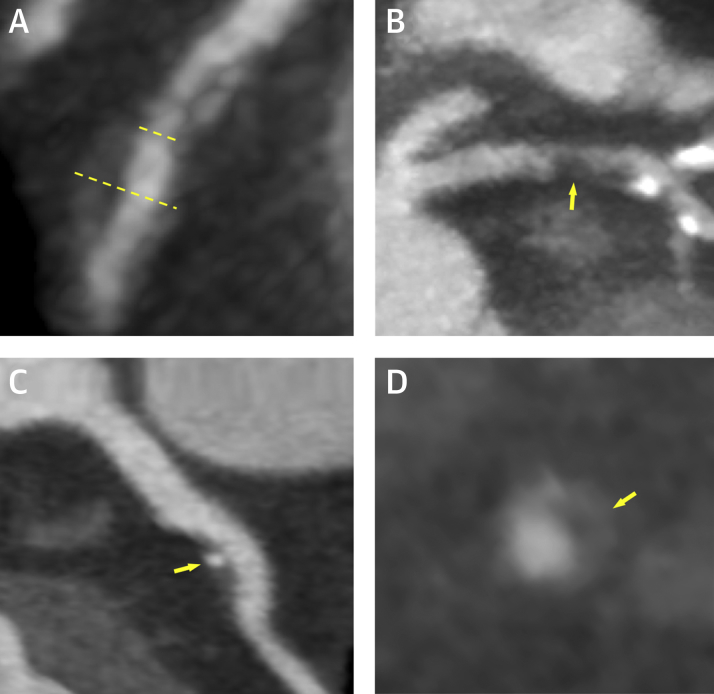
Coronary Plaque Characteristics Identified on Computed Tomography Coronary AngiographyCoronary atherosclerotic plaque features detected using computed tomography coronary angiography including (A) positive remodeling, (B) low-attenuation plaque, (C) spotty calcification, and (D) the “napkin ring” sign. Positive remodeling (A) was defined as an outer vessel diameter (long dashed line) that was 10% greater than the mean diameter of the segments immediately proximal (short dashed line) and distal to the plaque. Low-attenuation plaque (B) was defined as a focal central area of plaque with an attenuation density of <30 Hounsfield Units (yellow arrow). Spotty calcification (C) was defined as focal calcification within the coronary artery wall that measured <3 mm in maximum diameter (yellow arrow). The “napkin ring” sign (D) was defined as a central area of low-attenuation plaque with a peripheral rim of high attenuation (yellow arrow).